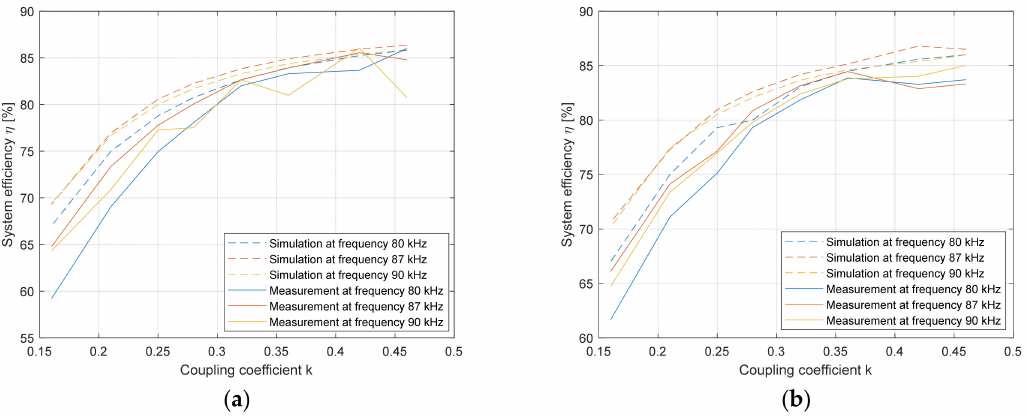
Figure 15. Comparison of the simulated and measured results: ( a ) single DD coil structure; ( b ) double DD coil structure. Experimental evaluation was performed for both single and double DD IPT